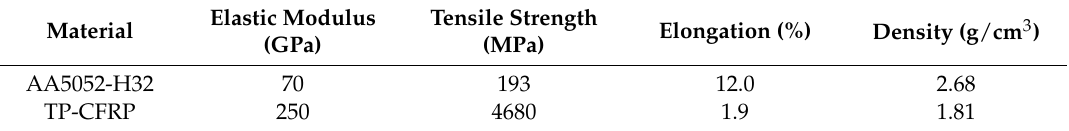
Table 1. Mechanical properties of AA5052-H32 and TP-CFRP.